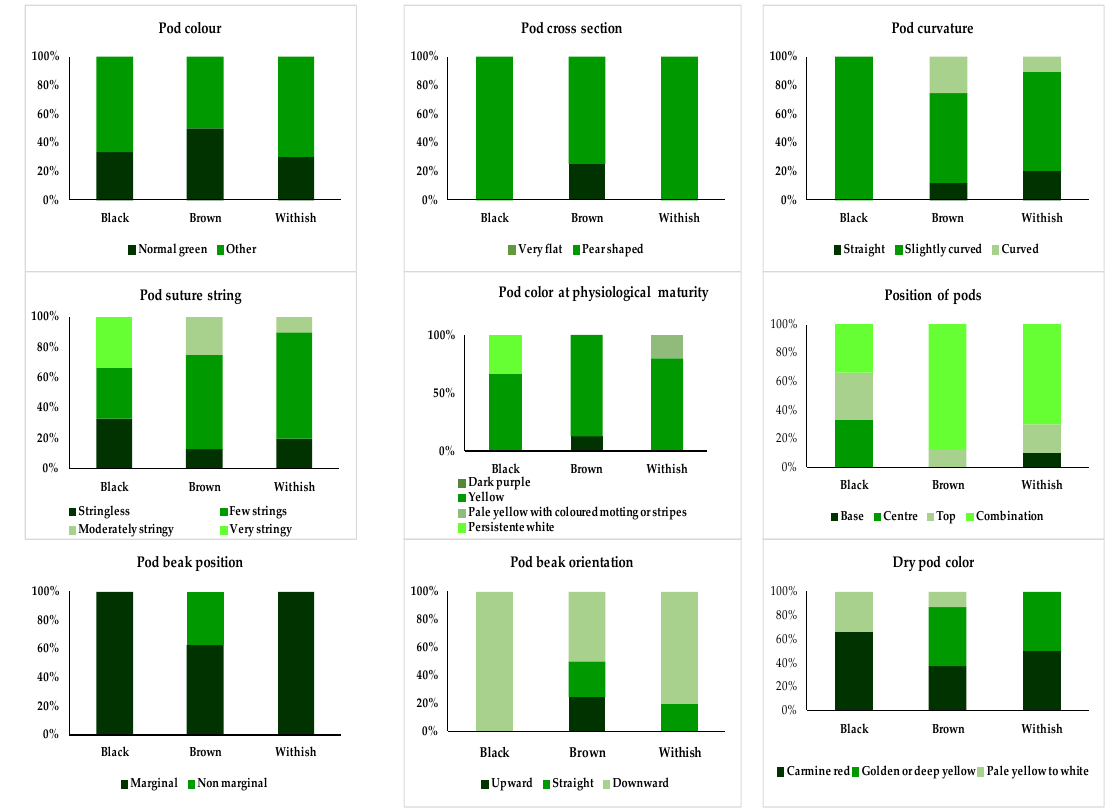
downward), and pod suture string (from stingless to very stringy). No variation was found for apparent seed veining, being absent in all cases. Figure 7. Pod traits of the 24 P. vulgaris accessions evaluated. Figure 7. Pod traits of the 24 P. vulgaris accessions evaluated.